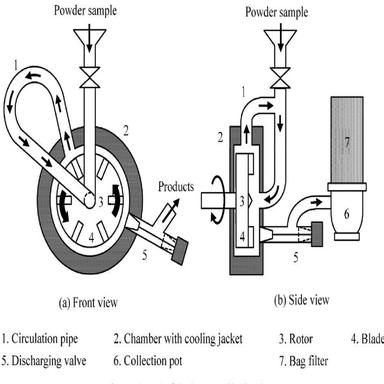
Schematic of the dry impact-blending device.